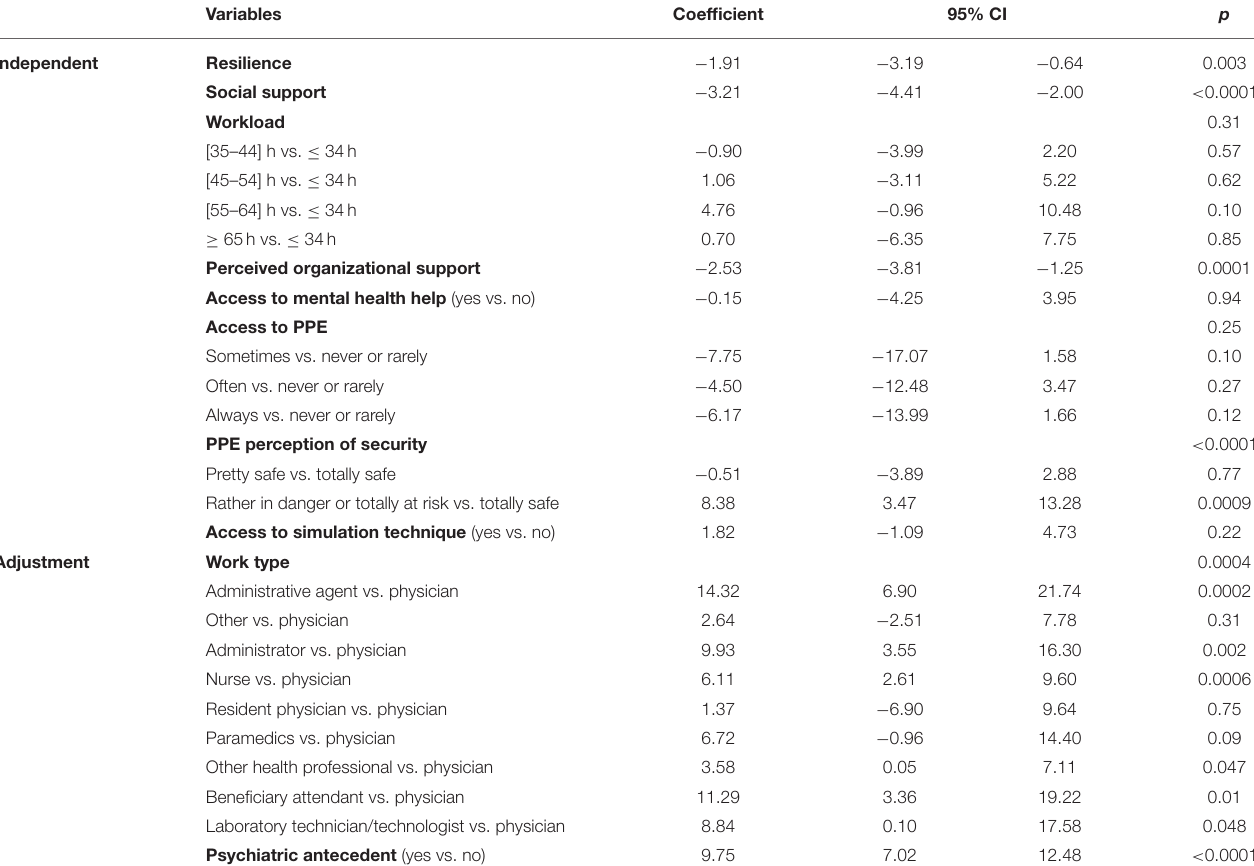
TABLE 4 | Adjusted coefficient, 95% confidence interval and p -values from multivariable linear regression analysis for PTSD symptoms among healthcare workers ( n = 426). Variables Coefficient 95% CI p Independent